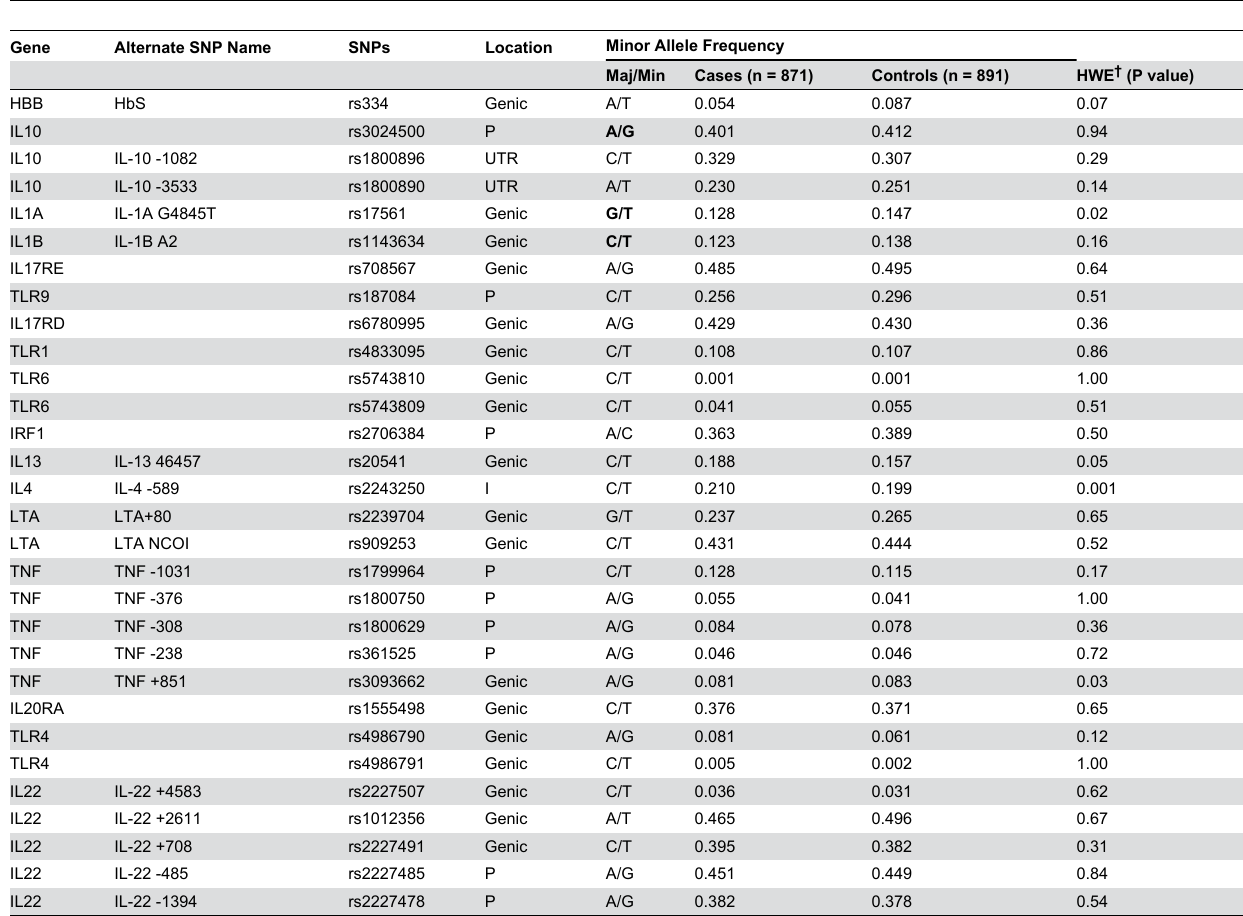
Table 2. Minor allele frequencies and Test of Hardy-Weinberg Equilibrium in selected candidate SNPs.